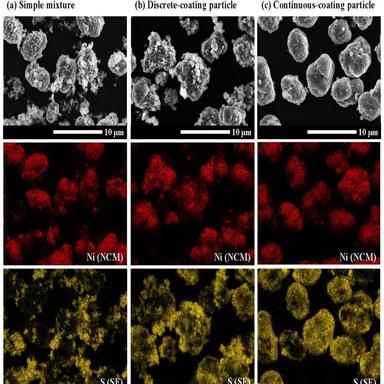
SEM and EDX mapping image of electrode powder with difference dry coating time of (a) simple mixture, (b) discrete-coating particles, and (c) continuous-coating particles.